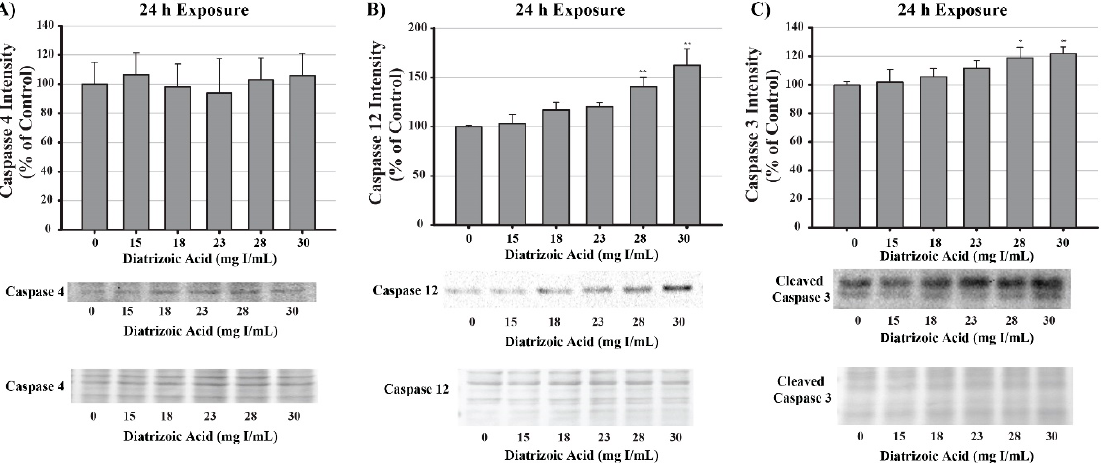
Figure 17. Diatrizoic acid e ff ects on the expression of caspase 4, caspase 12, and caspase 3 in HK-2 cells. DA induced apoptosis via caspase 3 and caspase 12 activation. Representative blot and cumulative densitometry for total caspase 4 ( A ), caspase 12 ( B ), and cleaved caspase 3 ( C ) protein expression following 24 h exposure to DA. Asterisks (* p < 0.05, ** p < 0.01) indicate statistical di ff erence from vehicle control. Protein loading reversible stain shown below respective protein. Each lane was loaded with 40 µ g protein. Values represent mean ± SEM for three independent